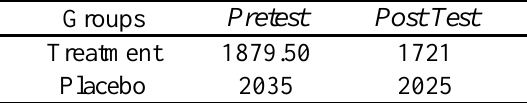
Table 02. Median Total Lymphocyte Total